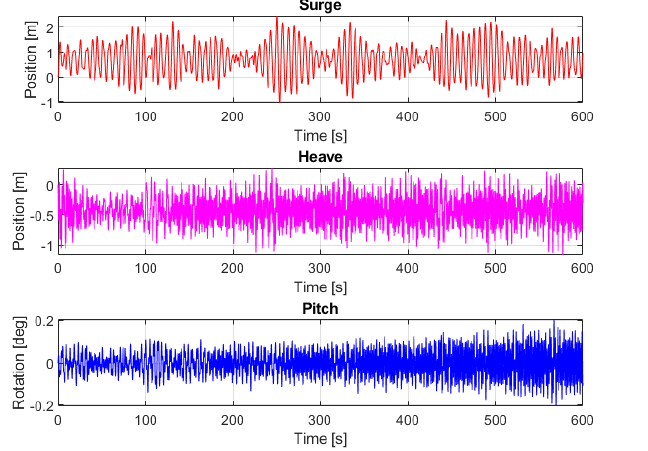
Figure 15. Surge, heave and pitch for Hs = 1.125 m, Te = 5.375 s and V = 8